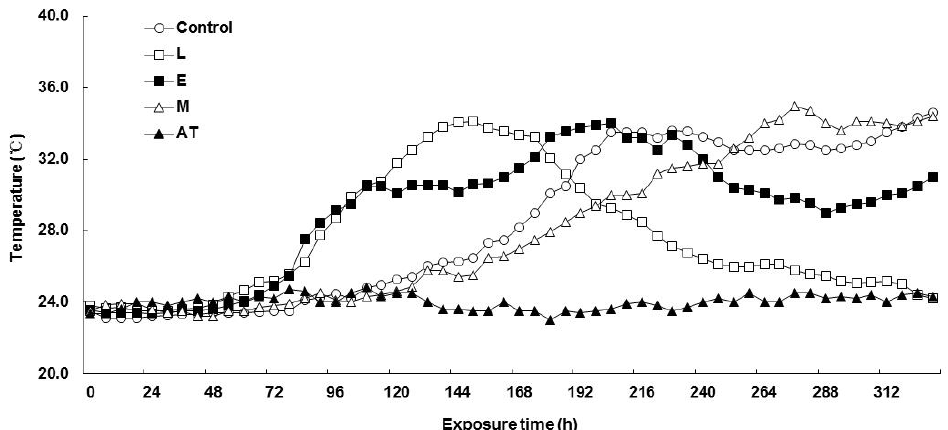
Figure 2. Effect of application of additives on the temperature change of Pleurotus eryngii spent mushroom substrate silages after exposure to aerobic conditions. L, lactic acid bacteria; E, cellulase; M, the mixture of lactic acid bacteria and cellulase; AT, ambient temperature.